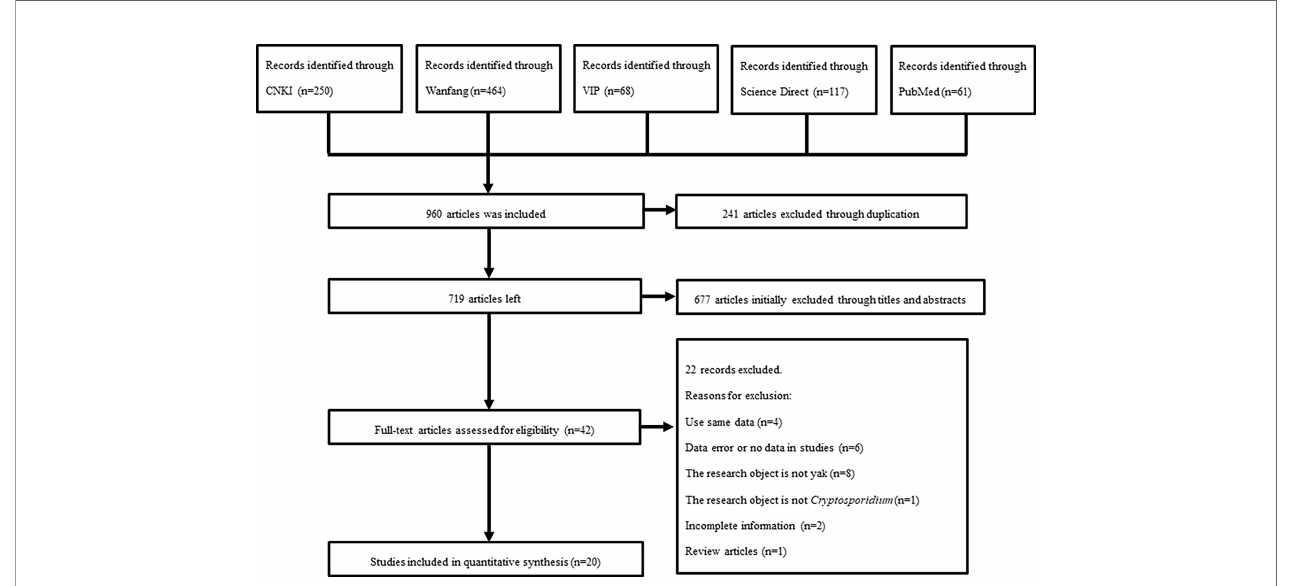
FIGURE 1 | Flow diagram of literature search and